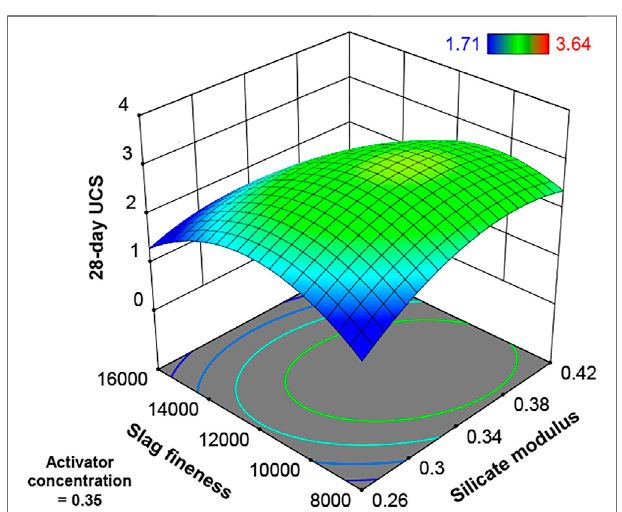
FIGURE 11 | Response-surface of the in fl uence of activator concentration and its interaction with silicate modulus for a slag fi neness of 12000 cm 2 /g.